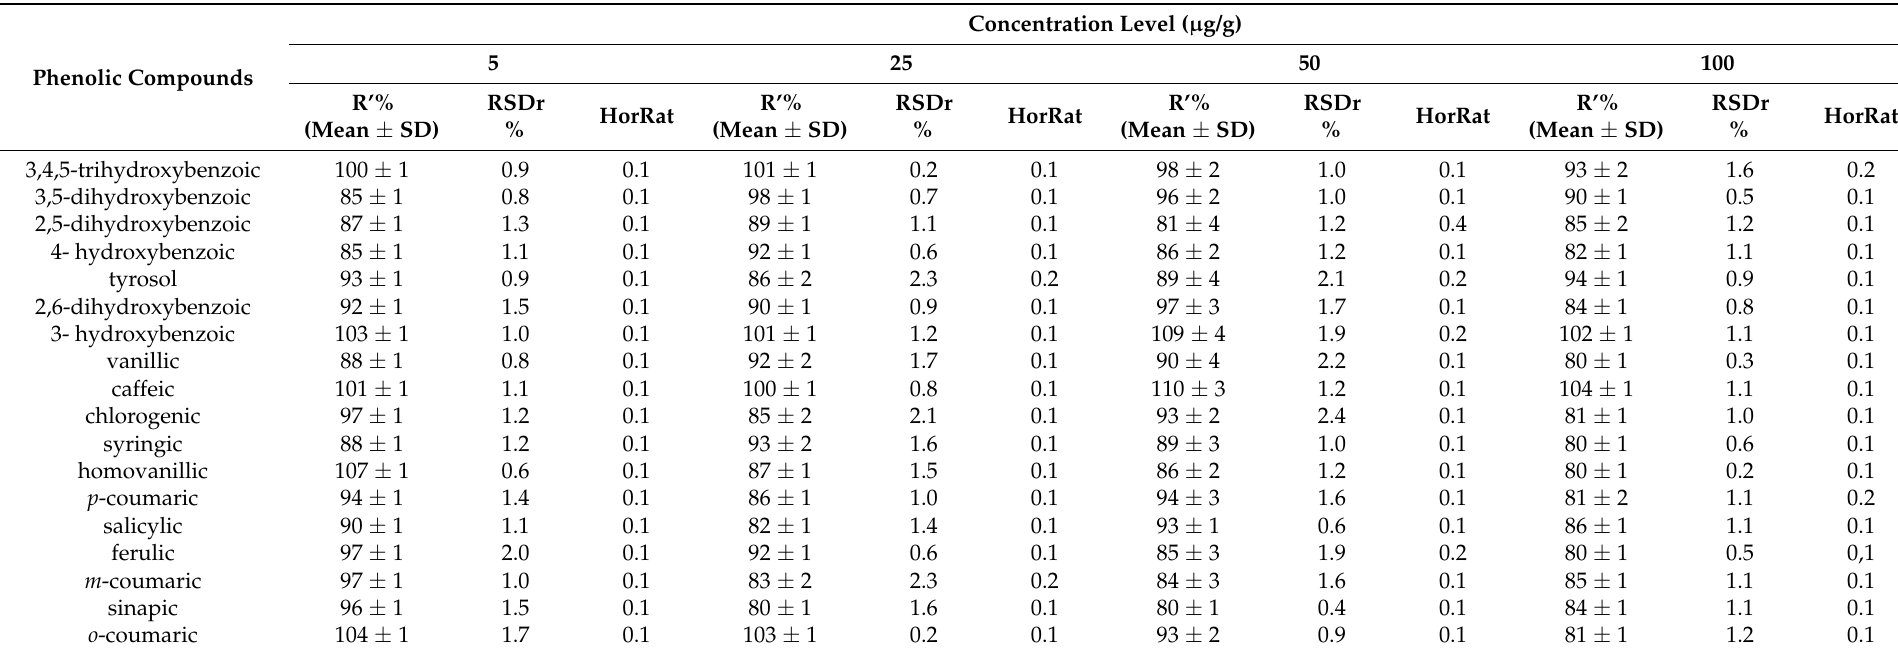
Table 4. Trueness (R’%) and precision (RSDr%) and Horwitz ratio value (HorRat) of the optimized method, based on four concentration levels (5, 25, 50, and 100 µ g/g) of phenolic compounds spiked brewing spent